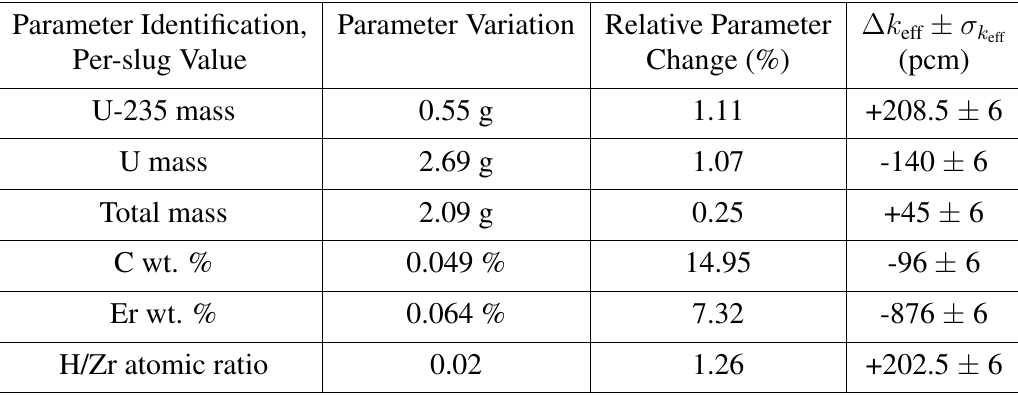
Table 2: Effect of Uncertainty in Fuel Material